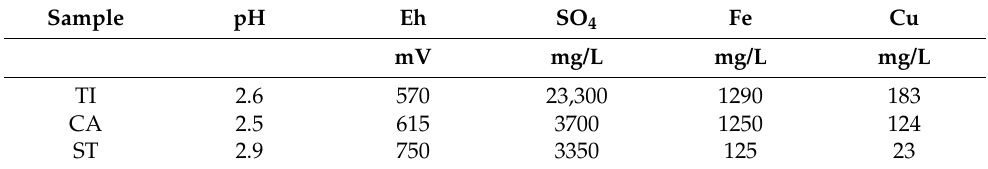
Table 1. Selected chemical parameters of the three samples of acidic mine water used in this